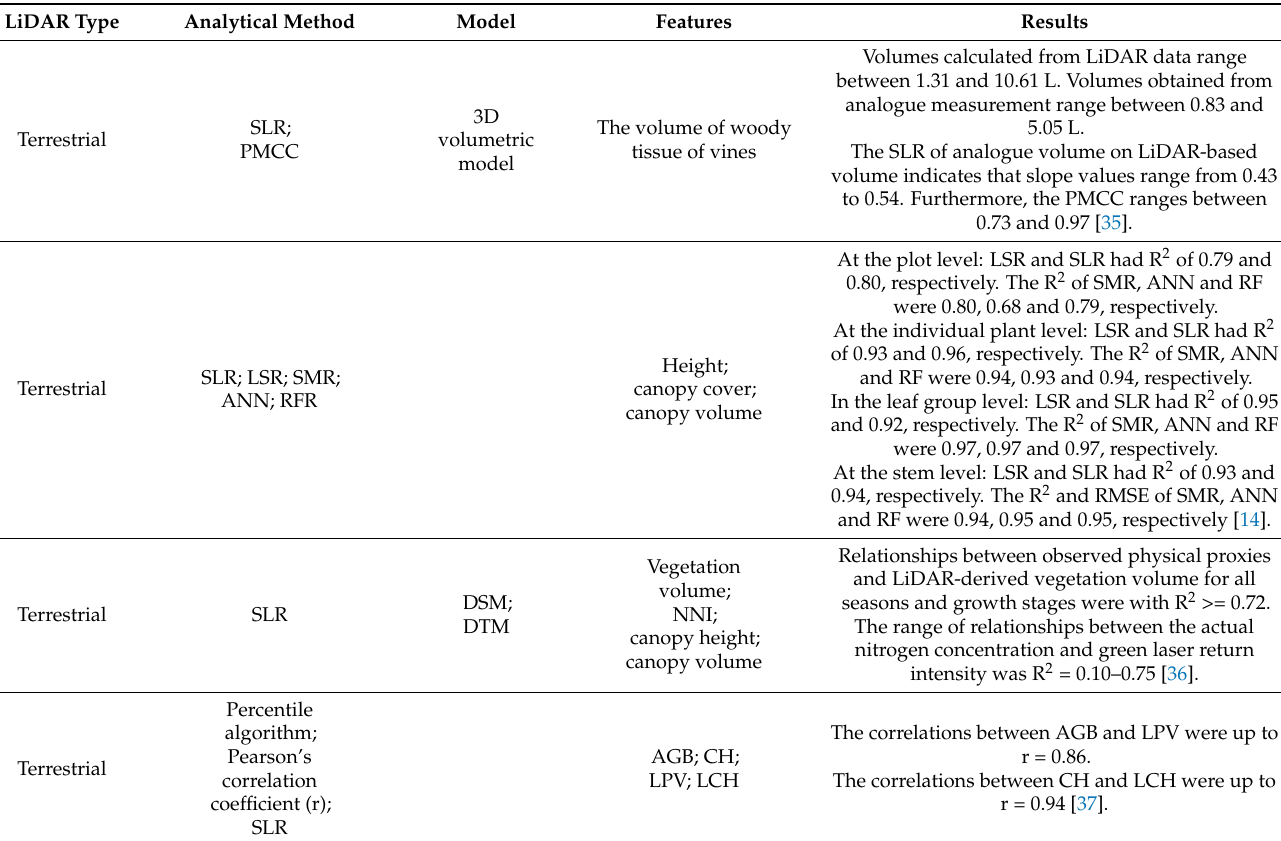
Table 3. Comparison of various aspects of LiDAR data in crop biomass